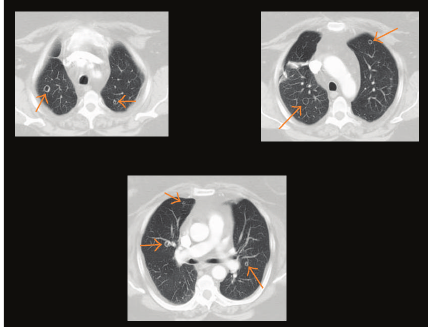
Figure 3: CT: multiple bilateral cavitary pulmonary